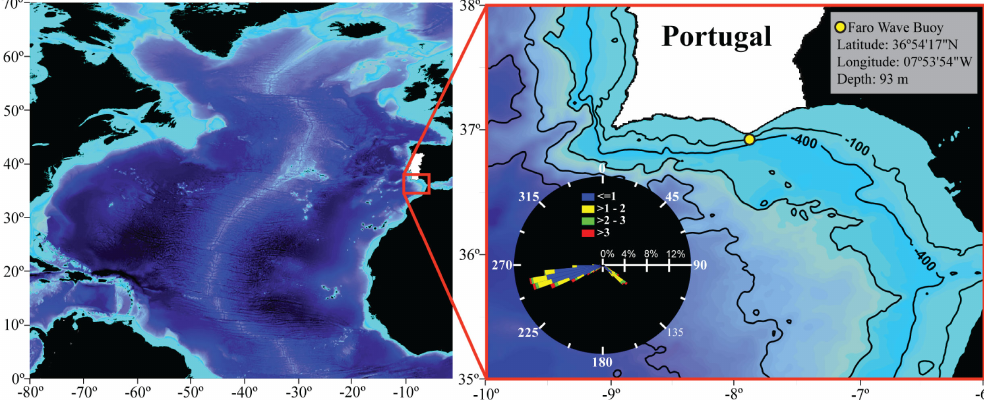
Fig. 1. The study area, including the location of the Faro buoy (the same as the simulated wave model point) and the wave rose distribution for the measured